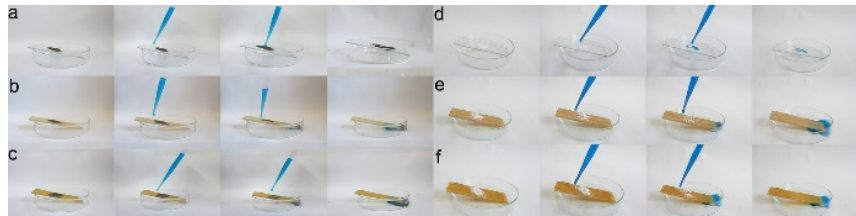
Figure 5. Self-cleaning soil performance of ( a ) raw plate, ( b ) LNU-26-, and ( c ) LNU-27-coated plate; self-cleaning chalk dust performance of ( d ) raw plate, ( e ) LNU-26-, and ( f ) LNU-27-coated plate.